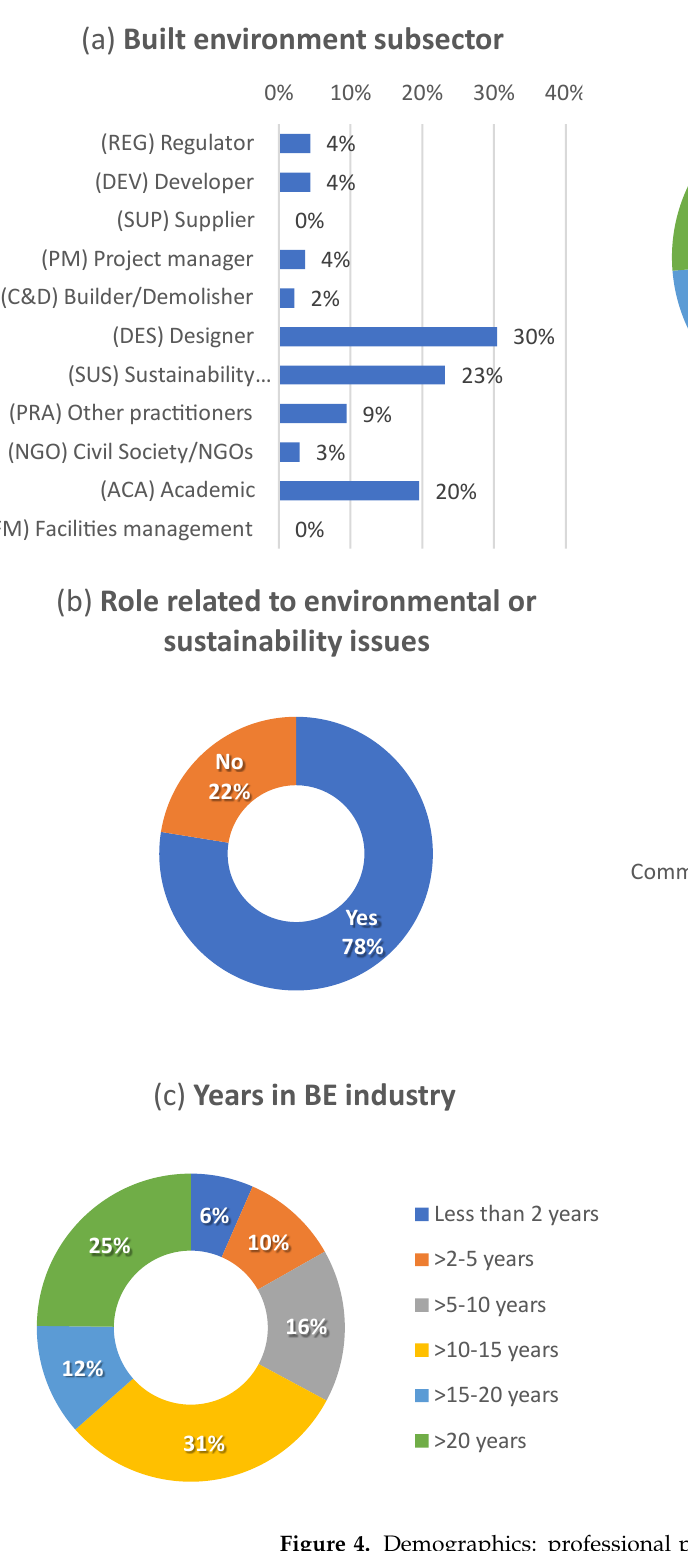
Figure 4. Demographics: professional profile of survey respondents regarding ( a ) BE subsector, ( b ) link to sustainability roles, ( c ) years in the sector, ( d ) size of organisation, ( e ) domain/scale of engagement, and ( f ) if company operates in more than one country.